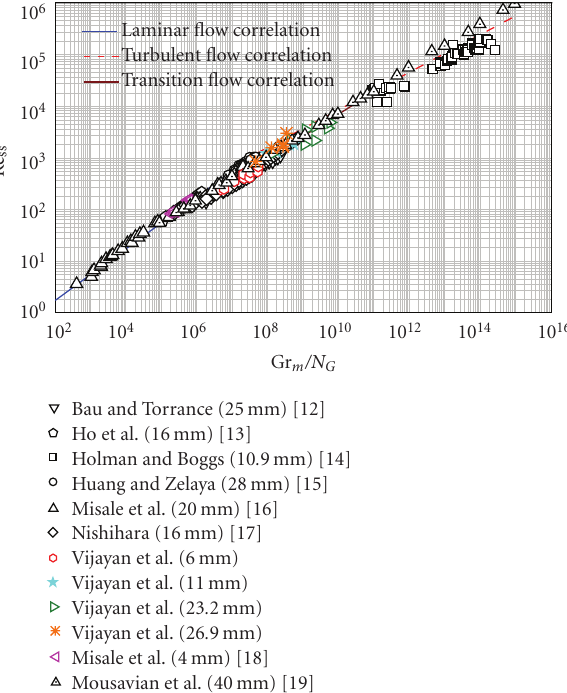
Figure 3: Steady state performance of single-phase loops di ff ering in diameter (dimensions in the bracket denote the loop diameter used by di ff erent